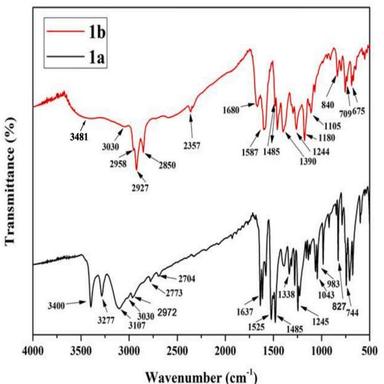
FT-IR spectra of 2-(5-amino-1,3,4-thiadiazol-2-yl) phenol (1a) and 2-hydroxy-5-((5-(2-hydroxyphenyl)-1,3,4-thiadiazol-2-yl)diazenyl)benzoic acid (1b).